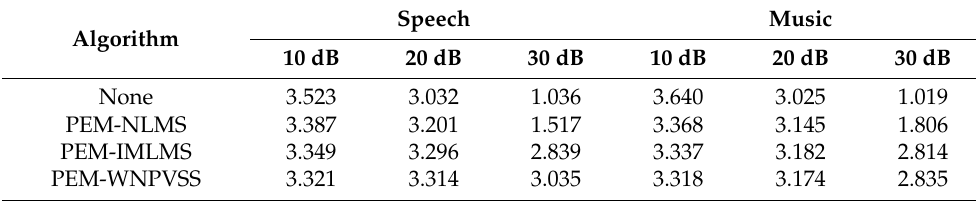
Table 3. PESQ score of the three